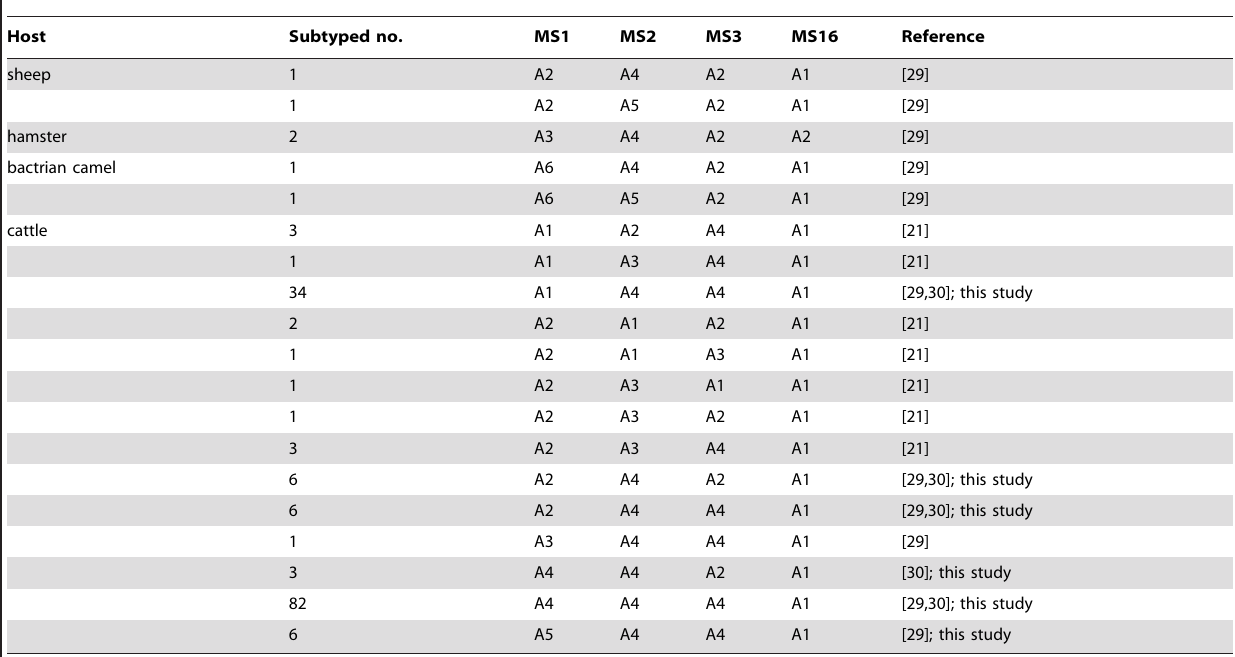
Host Subtyped no.